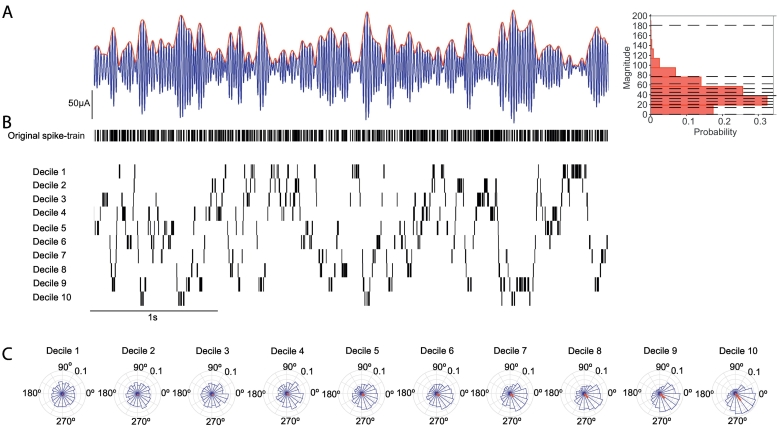
Magnitude dependent phase-locking analysis - schematic illustration. A, Left, Example filtered LFP trace in the beta-frequency range (25–35 Hz) (blue) with instantaneous magnitude of the Hilbert envelope (red). Right, Example distribution of spike-time magnitudes for the example recording shown in A (solid black line: median). Dashed black lines indicate decile divisions. B, Original spike train (top) and spike trains generated by separating spikes occurring within each decile. Data corresponds with the LFP oscillation shown in (A). C, Circular plots show the distribution of spike phases relative to the LFP beta oscillation for each decile. The red line shows the mean phase and vector sum. The vector length becomes longer and the spike phase distribution becomes more peaked with increasing deciles (magnitude of the beta oscillation).